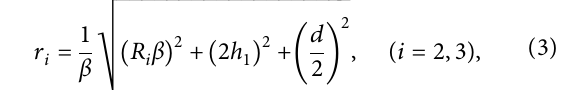
Figure 2: Plane development of rope winding on the drum.